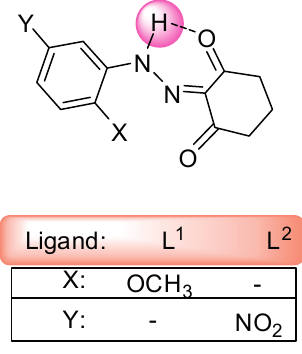
Figure 1. Structures of the ligands L 1 and L 2